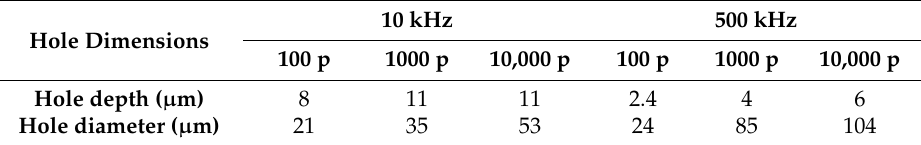
Table 2. Characteristics of holes drilled in aluminum in water. Table 2 . Characteristics of holes drilled in aluminum in